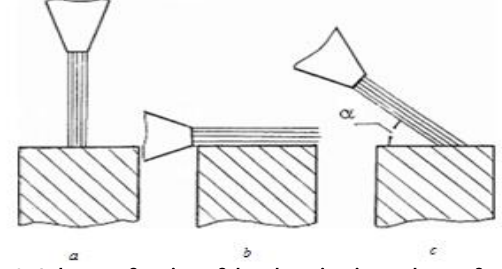
Fig. 2. Scheme of action of the abrasive jet to the